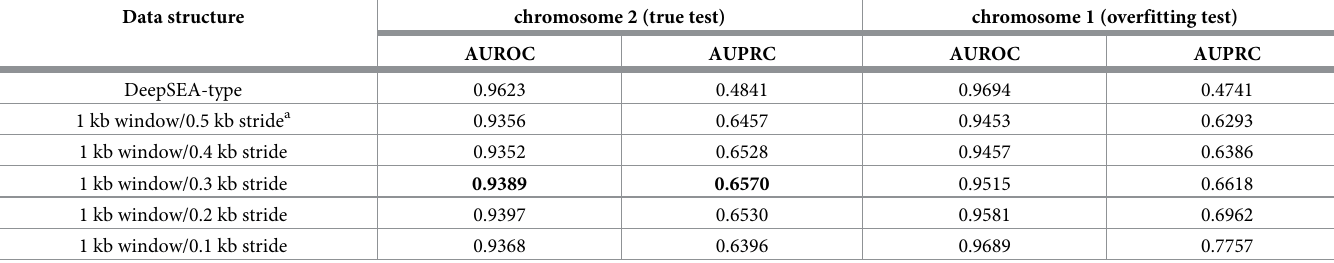
Table 2. A performance comparison between data